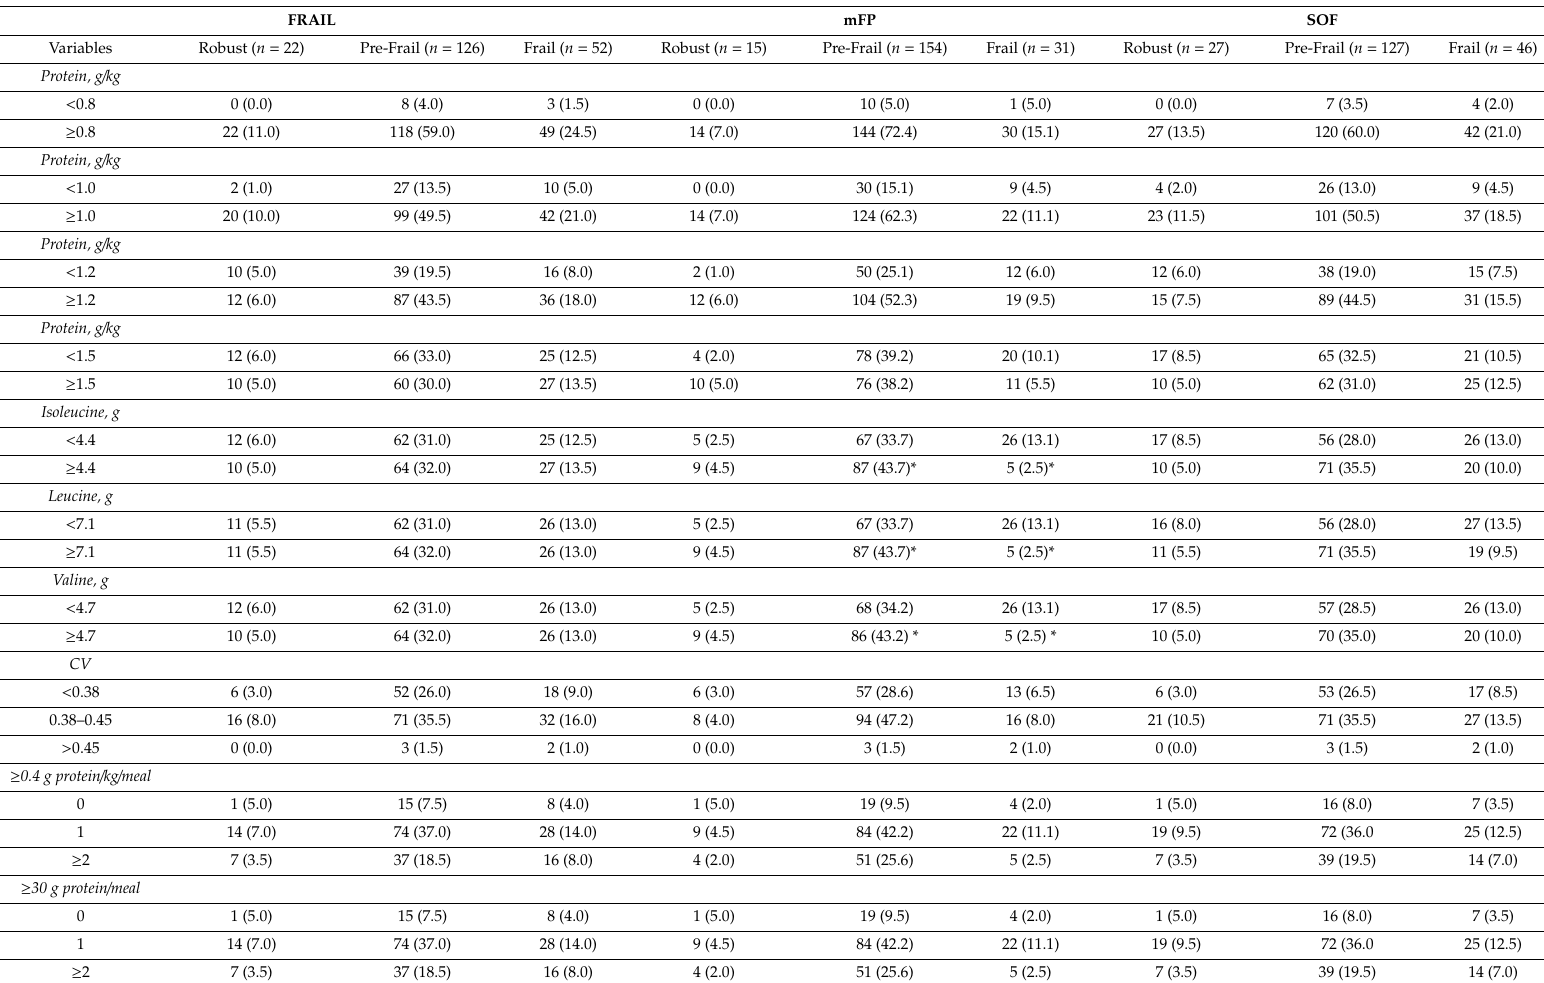
Table 2. Frequency (%) of distribution of older adults according to diet characteristics and frailty status. FRAIL mFP SOF Variables Robust ( n = 22) Pre-Frail ( n = 126) Frail ( n = 52) Robust ( n = 15) Pre-Frail ( n = 154) Frail ( n = 31) Robust ( n = 27) Pre-Frail ( n = 127) Frail ( n = 46) Protein, g / kg < 0.8 0 (0.0) Protein, g / kg < 1.0 Protein, g / kg < 1.2 Protein, g / kg < 1.5 12 (6.0) Isoleucine, g < 4.4 Leucine, g < 7.1 Valine, g < 4.7 CV <